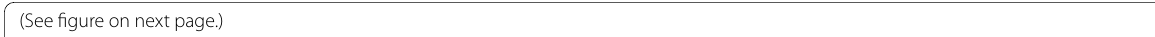
figure on next Fig. 1 Bivariate Pearson correlation between methods for calculating an overall score on the WHODAS 2.0. All procedures transform the results to a 0–100 scale. The results are based on Swedish psychiatry outpatients (n 780). NOTE. The Rasch 0–100 scale refers to data from new analyses where = all five rating scale categories were used for each item. a Correlation between person measures is calculated according to the complex (IRT-based) model in the WHODAS 2.0 manual and the Rasch partial credit model (r 0.90, p < 0.001). b Correlation between person measures is calculated = according to the simple model in the WHODAS 2.0 manual (percentage of raw scores) and the Rasch partial credit model (r 0.89, p < 0.001). c = Correlation between person measures is calculated according to the simple model in the WHODAS manual (percentage of raw scores) and the complex model in the WHODAS manual (IRT-based) (r 0.99, p < =